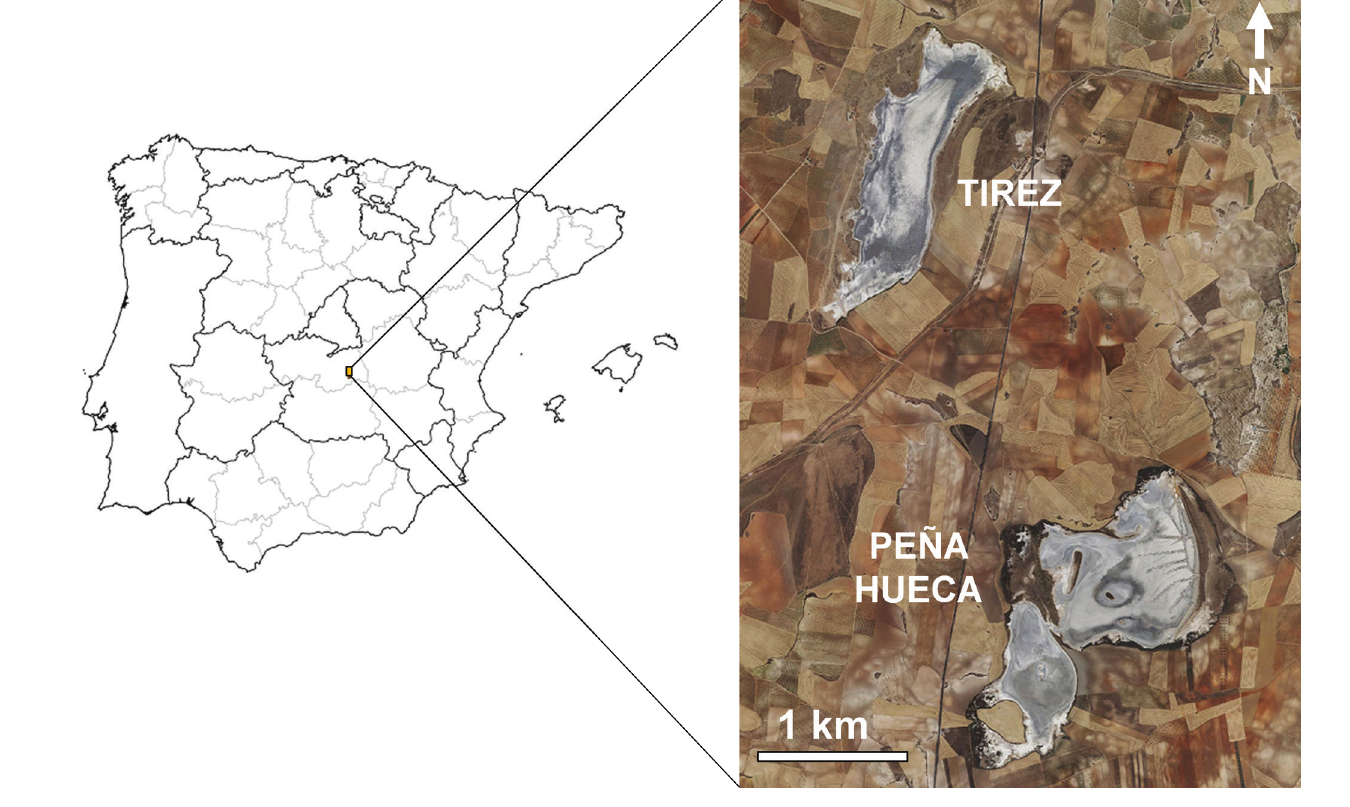
Fig. 1. Map of the study area (Villacañas, Toledo Province, Central Spain) showing the location of the hypersaline lagoons Tirez and Peña